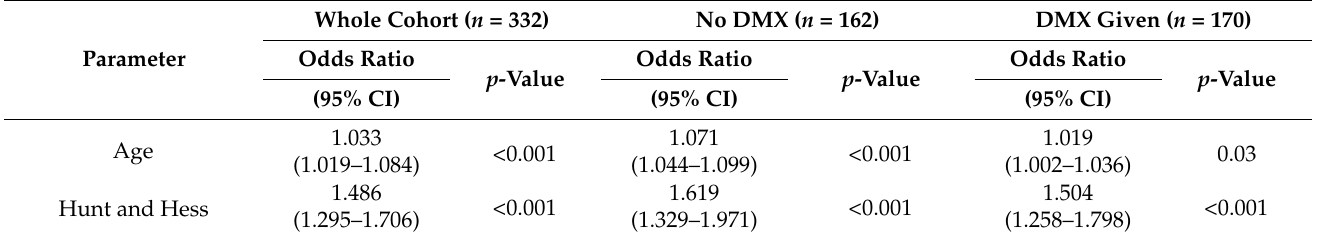
Table 5. Cox regression analysis for an unfavorable outcome at 6